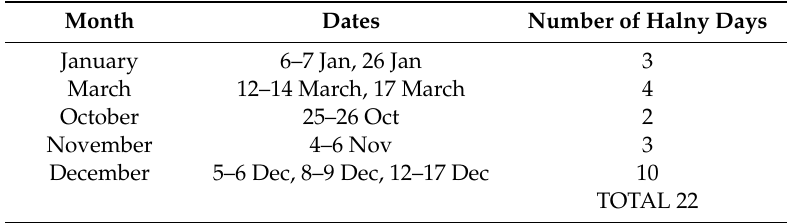
Table 2. Occurrence of halny and number of days a ff ected in year